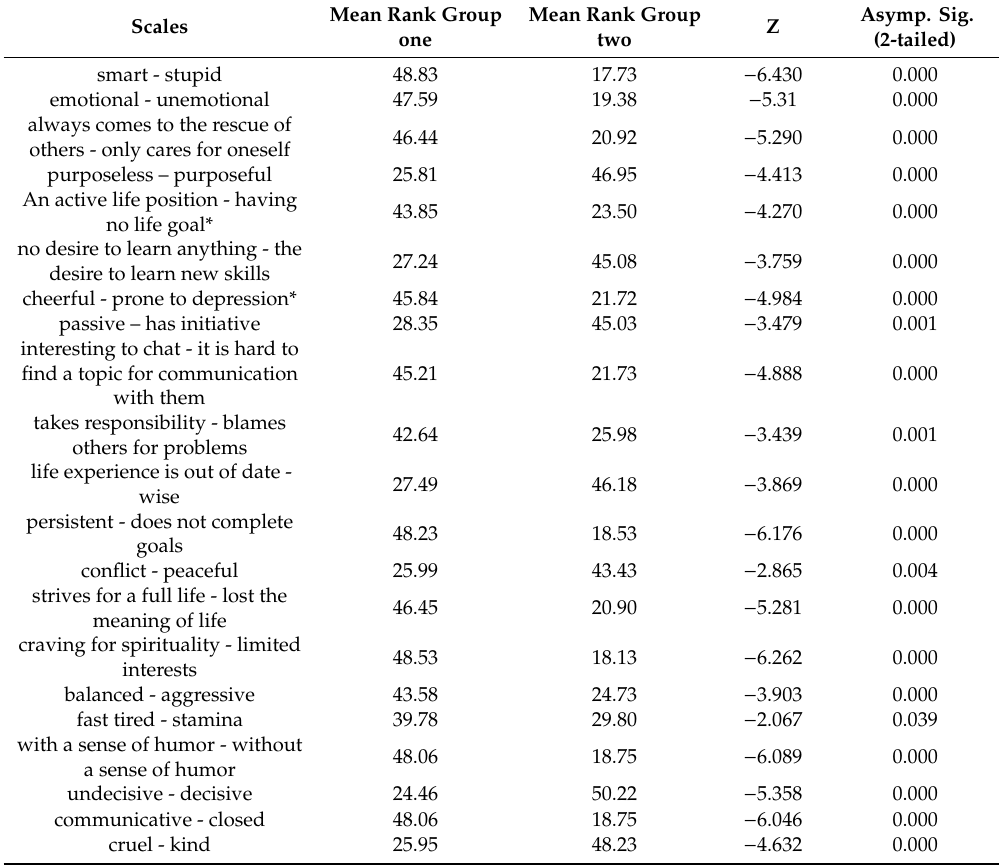
Table 3. Comparison of groups of undergraduate students and postgraduates by assessments after watching the